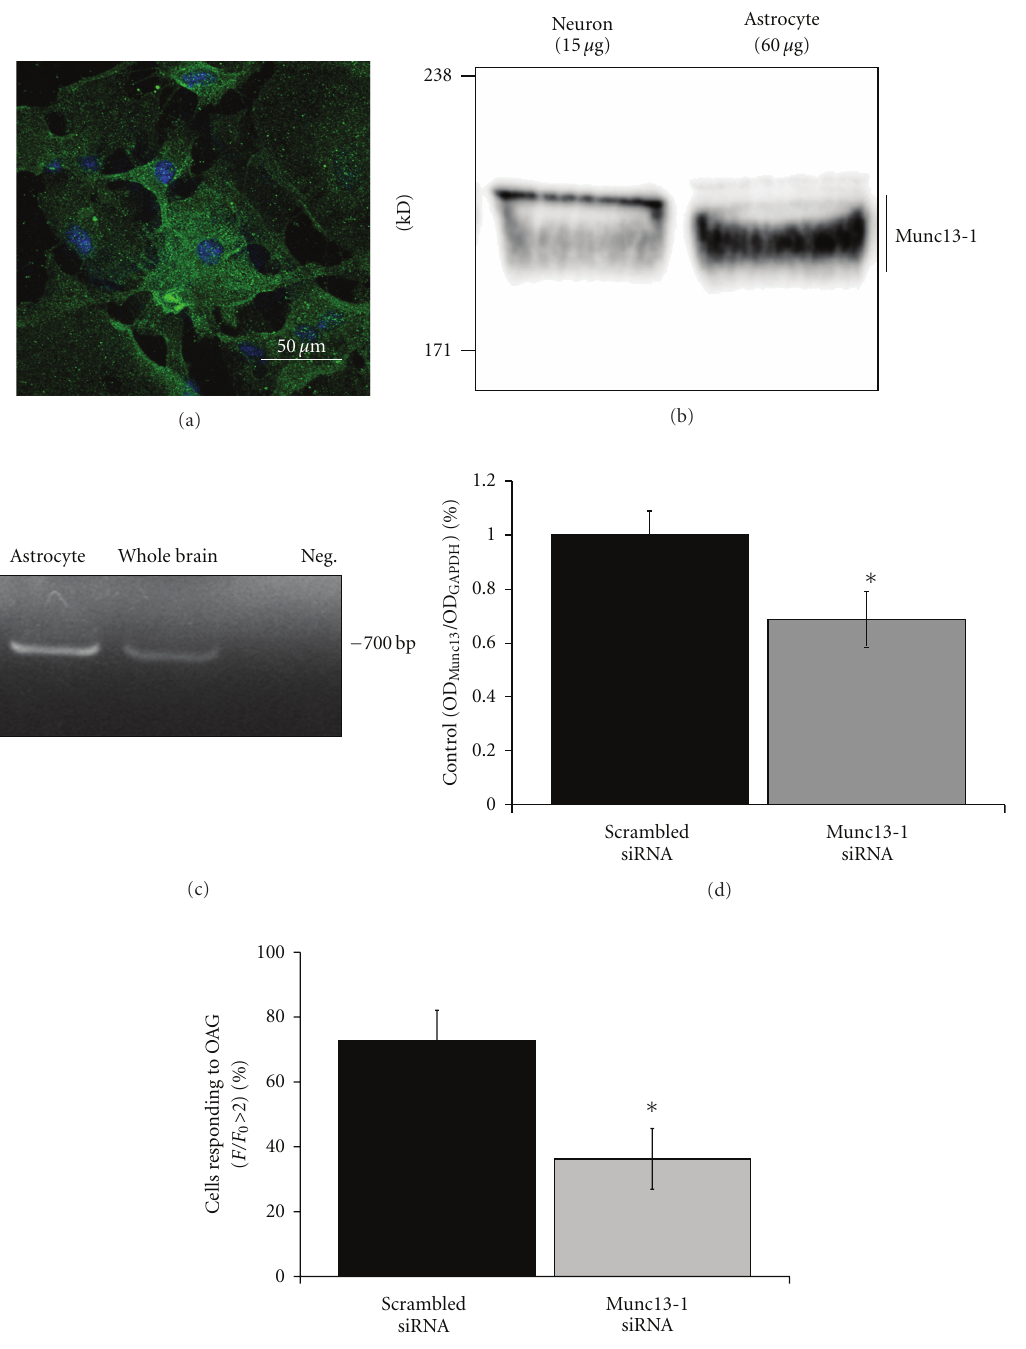
Figure 6: The Munc13-1 protein is expressed in cultured astrocytes and reduction of Munc13-1 expression reduces astrocytic ATP release. (a) Immunocytochemistry for Munc13-1 in cultured astrocytes demonstrates expression of Munc13-1 in these cells: (green: Munc13-1, blue: DAPI). (b) Western blotting for Munc13-1 demonstrates a band at the expected size ( ∼ 200 kD). Gel lanes were loaded with 60 µ g of cultured mouse astrocyte protein or 15 µ g of protein extracted from cultured mouse cortical neurons. (c) RT-PCR with primers designed against Munc13-1 of whole mouse brain mRNA and mRNA extracted from cultured astrocytes demonstrated a band for Munc13-1 at the expected size. Sequencing of these bands confirmed the presence of Munc13-1 in cultured astrocytes. (d) siRNAs designed against mouse Munc13-1 reduce the expression of Munc13-1 in transfected mouse astrocytes as measured by Western blot. Optical density of the